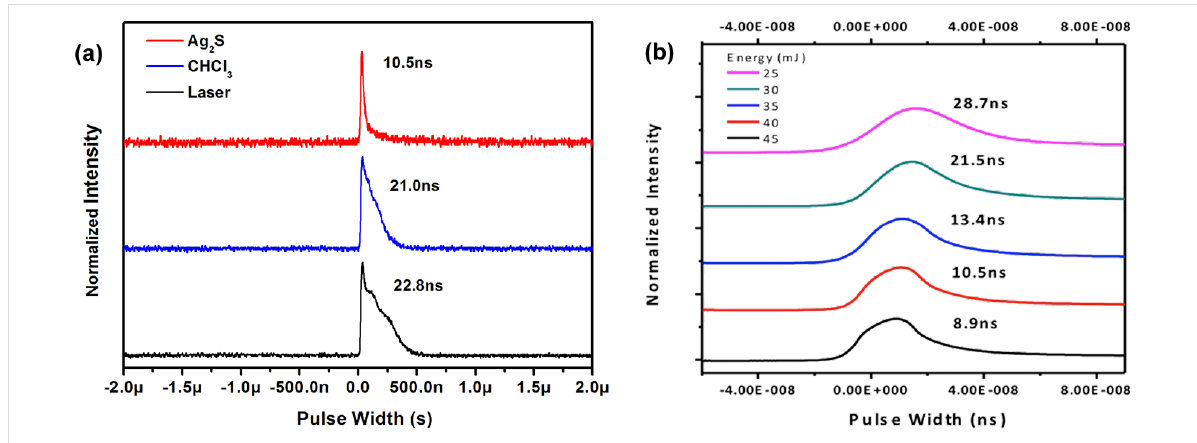
Figure 6: (a) Normalized waveforms of laser pulse and transmission pulse at the same pump energy level; (b) normalized waveforms of transmission pulse of Ag 2 S quantum dots showing width curve at different pump energy.